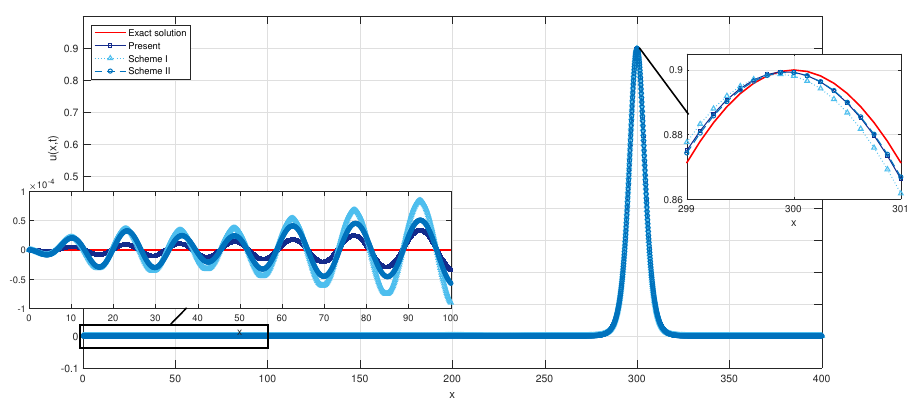
Figure 8. Numerical solutions with ∆ x = ∆ t = 1/8 and T = 0 to